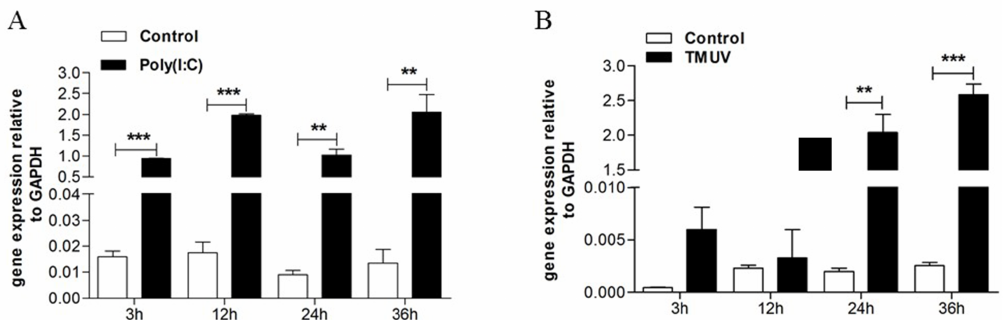
Figure 1. Time course study of goose myxovirus resistance protein (goMx) messenger RNA (mRNA) expression upon polyinosinic polycytidylic acid (Poly(I:C)) stimulation and Tembusu virus (TMUV) infection. Goose embryo fibroblast (GEF) cells were either induced with Poly(I:C) (30 mg/mL; 50 µ L/well) or TMUV (1000 50% tissue culture infection dose (TCID 50 ); 100 µ L/well), and total RNA was harvested at designated time points and reverse transcribed into complementary DNA (cDNA). The resultant cDNA was used as the template in a quantitative PCR reaction, using primers specific for goMx, and glyceraldehyde 3-phosphate dehydrogenase (GAPDH) was used as an internal reference. ( A ) The mRNA expression levels of goMx against Poly(I:C) stimulation in GEF. ( B ) Analyses of goMx transcript levels post-TMUV infection in GEF. Each time point was assayed in triplicate, with error bars given as mean ± SD. Error bars indicate standard error. Asterisks (*) mark the significant difference between experimental and control groups (** p < 0.01; *** p < 0.001).